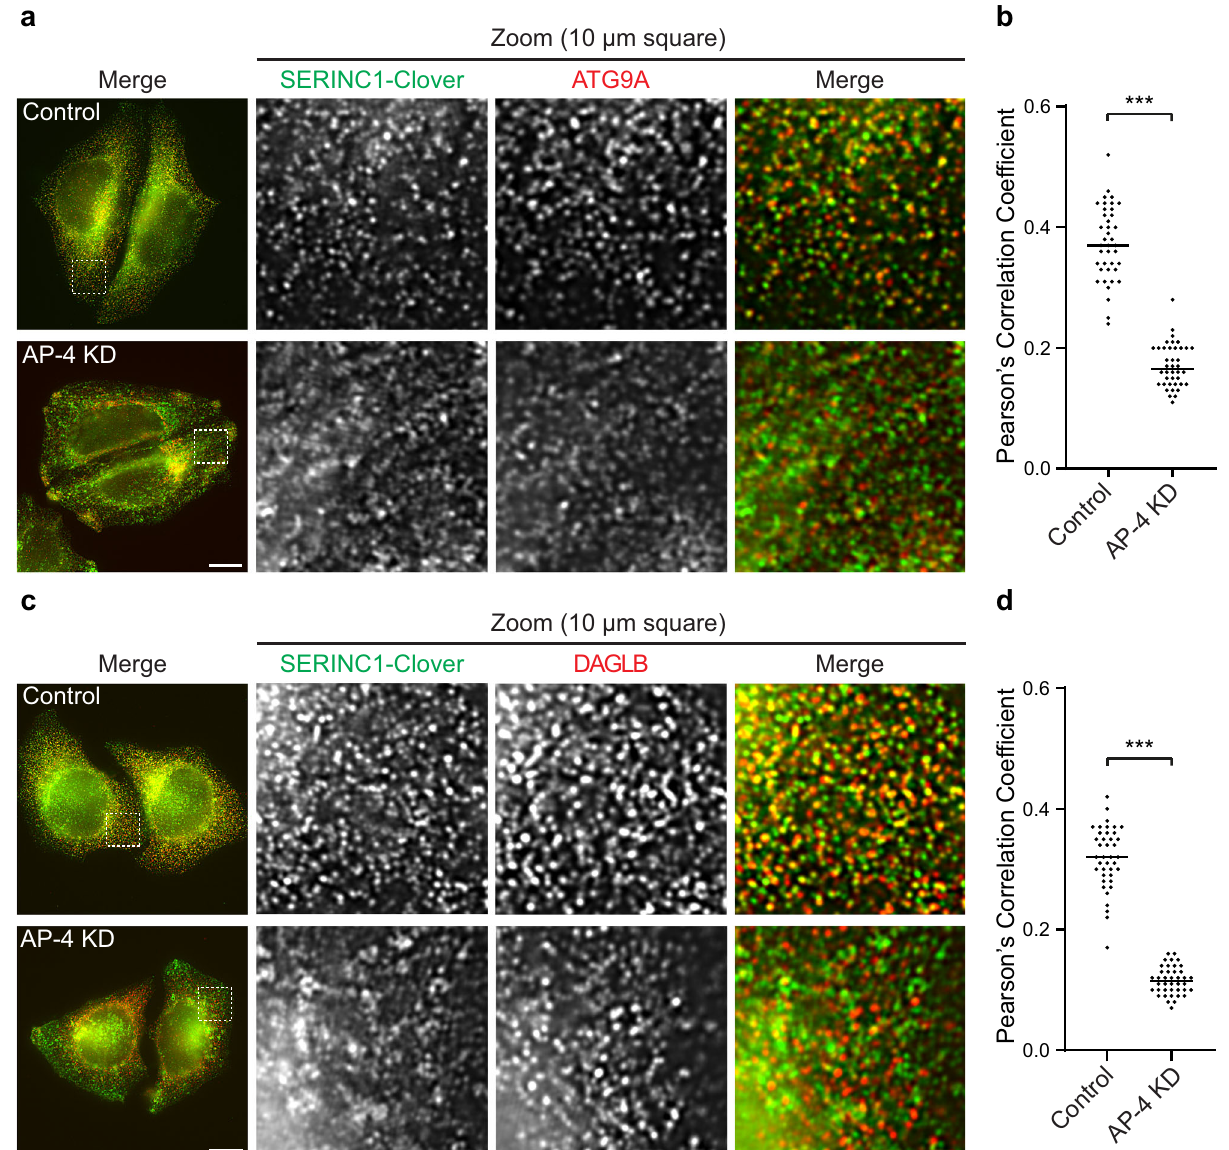
Fig. 5 DAGLB and ATG9A colocalise with SERINC1 in an AP-4-dependent manner. HeLa cells tagged endogenously with Clover (modi fi ed GFP) at the C-terminus of SERINC1 were transfected with siRNA to knock down (KD) AP-4, or were transfected with a non-targeting siRNA (Control). a Super- resolution structured illumination microscopy (SR-SIM) was used to image SERINC1-Clover (via anti-GFP; green) and anti-ATG9A (red).